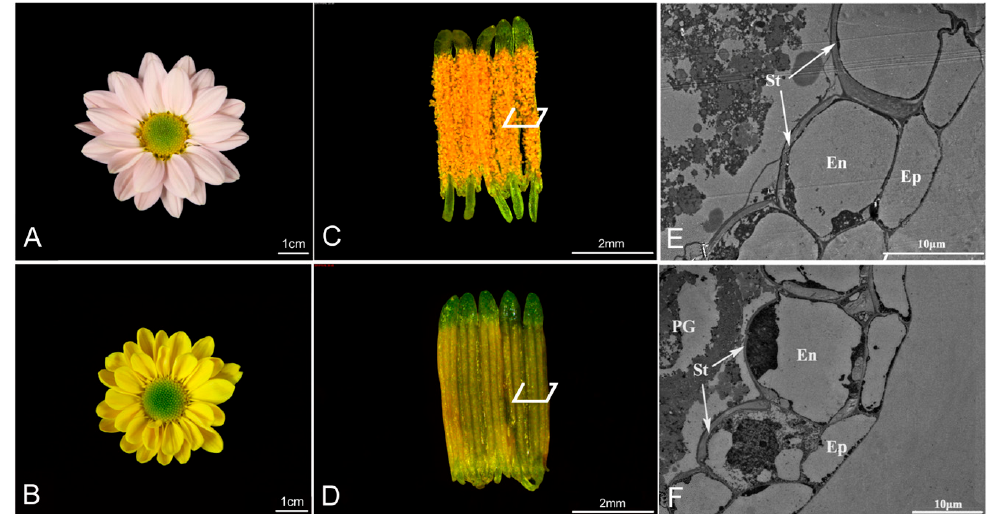
Figure 1. Morphological and anatomical features of anthers of chrysanthemum cultivars, ‘Qx-097 ′ and ‘Qx-115 ′ . ( A ) Blooming inflorescence of ‘Qx-097 ′ . ( B ) Blooming inflorescence of ‘Qx-115 ′ . ( C ) Five dehiscing anthers of ‘Qx-097 ′ . ( D ) Five indehiscent anthers of ‘Qx-115 ′ . ( E ) Cross-section of the ‘Qx-097 ′ anther observed under a transmission electron microscope (TEM). ( F ) Cross-section of the ‘Qx-115 ′ anther observed under TEM. En, endothecium; Ep, epidermis; PG, pollen grain; St, secondary thickening. Int. J. Mol. Sci. 2018 , 19 , x FOR PEER REVIEW